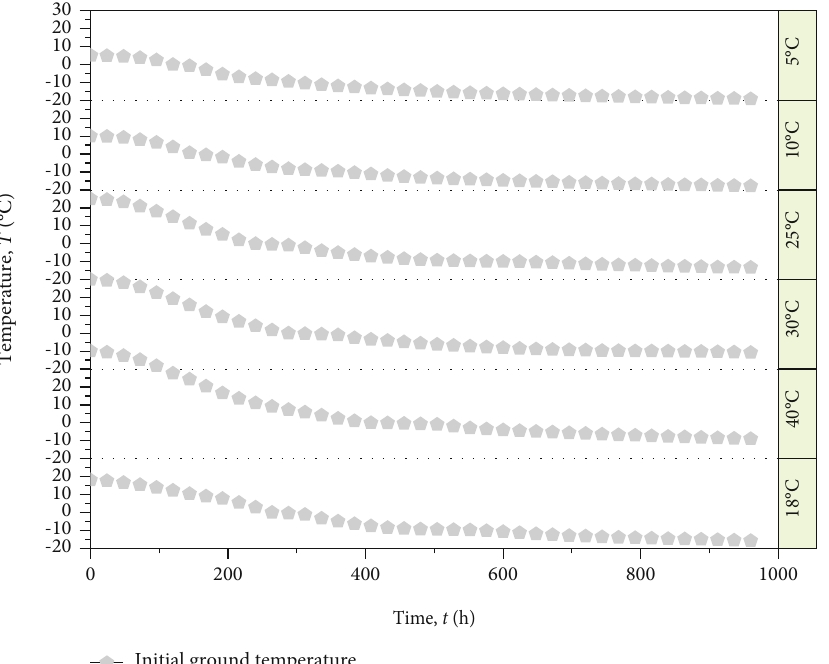
Figure 11: E ff ect of initial ground temperature on temperature fi eld